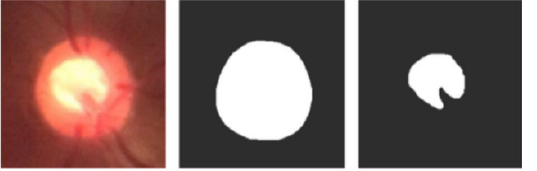
Figure 5. Example of optic disc and optic cup masks used in segmentation algorithms.